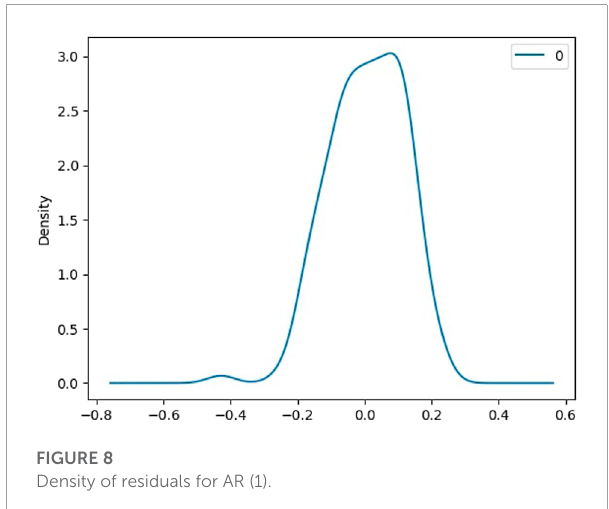
FIGURE 8 Density of residuals for AR